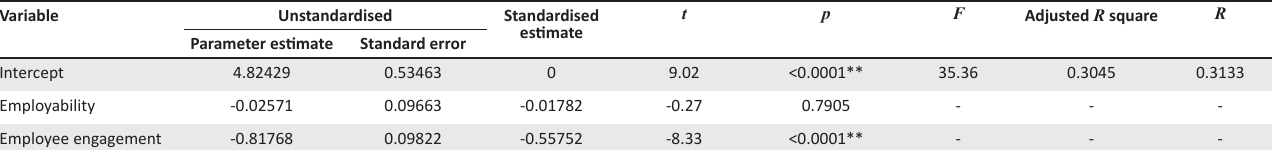
TABLE 6: Multiple regression statistics summary: Burnout as a dependent variable and employee engagement and self-perceived employability as an independent